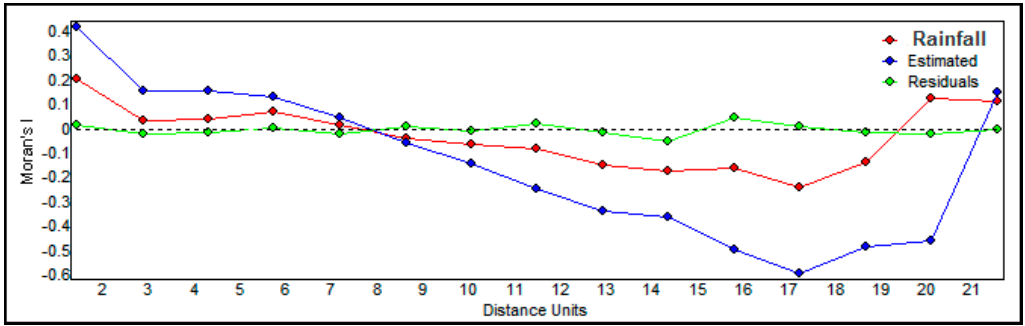
Figure 25. Moran’s I statistics of the GWR model.